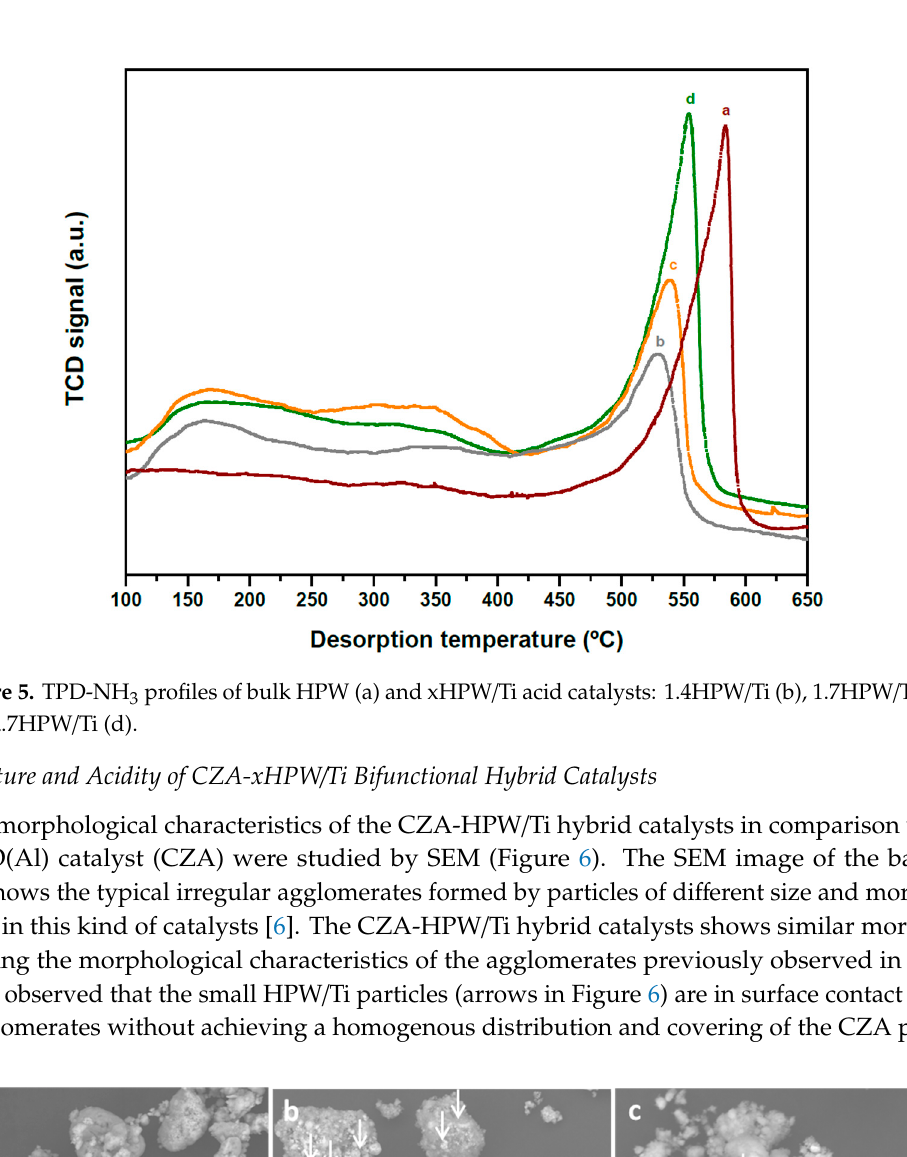
Figure 5. TPD-NH 3 profiles of bulk HPW (a) and xHPW/Ti acid catalysts: 1.4HPW/Ti (b), 1.7HPW/Ti (c) and 2.7HPW/Ti (d). Table 2. Quantitative data from TPD-NH 3 profiles of xHPW/Ti acid catalysts. Area